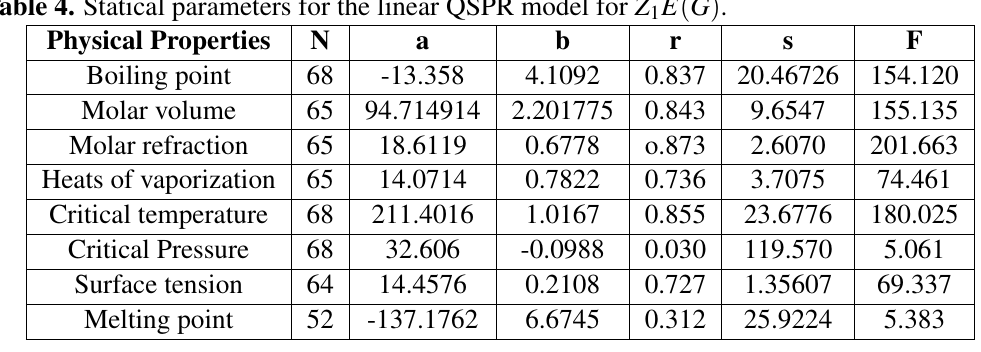
Table 4. Statical parameters for the linear QSPR model for Z